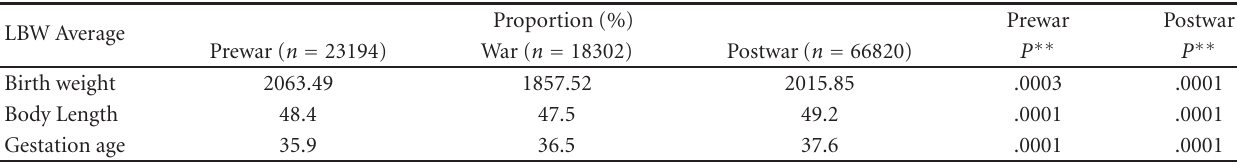
Table 3: Average birth weight, body length, gestation age, and Ponderal index of LBW newborn in the Clinic for Gynaecology and